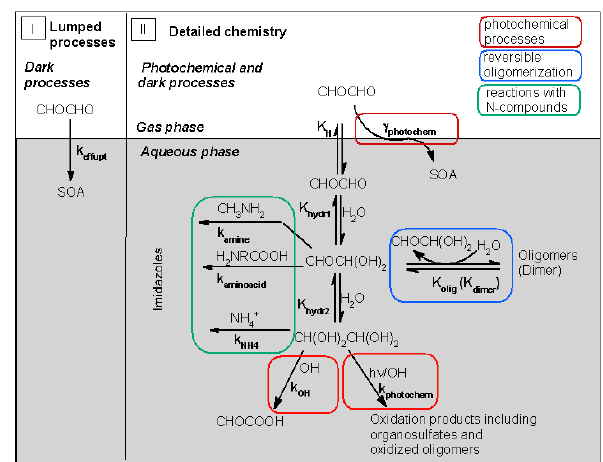
Fig. 1. Reaction scheme of glyoxal reactions in the aqueous phase based on literature and data derived in the present study. The termi- nology of the processes refers to the processes as included in Table 2 and in the text; all rate constants k and equilibrium constants K are defined in the Appendix. (I) k effupt refers to lumped parameteriza- tion of multiple dark processes (Sect. 3.1.); (II) shows all individual photochemical and dark processes discussed in Sects. 3.2 and